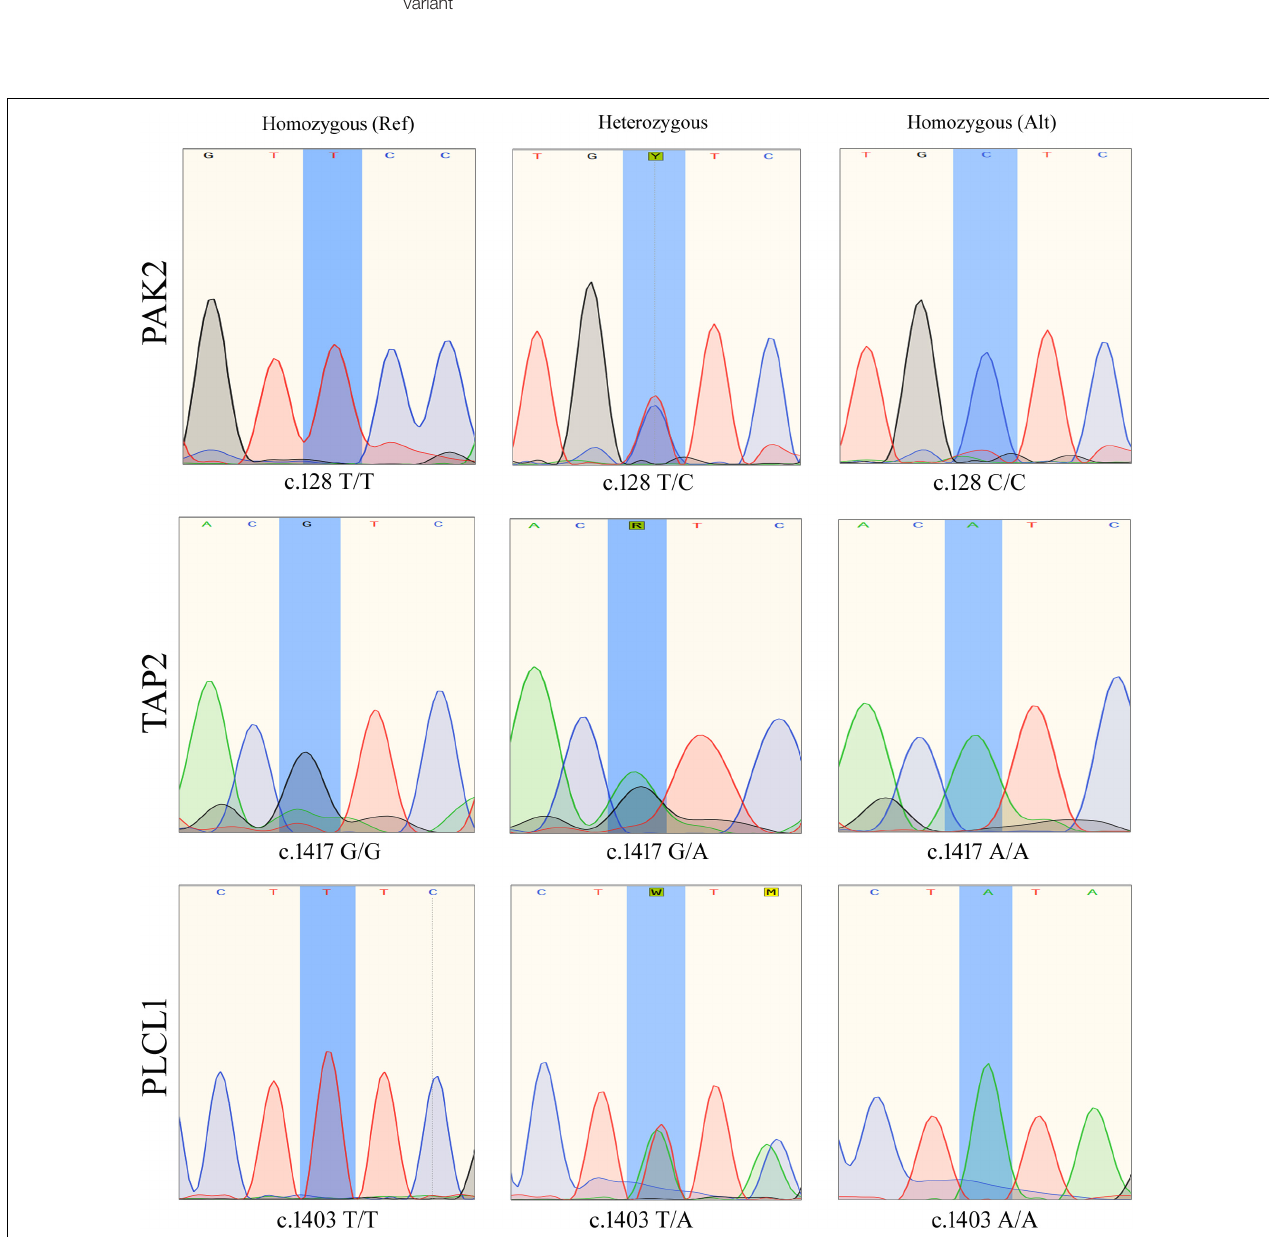
FIGURE 2 | Sanger sequencing results showing different genotypes of PAK2 (c.128T > C), TAP2 (c.1417G > A), and PLCL1 (c.1403T > A) variants.